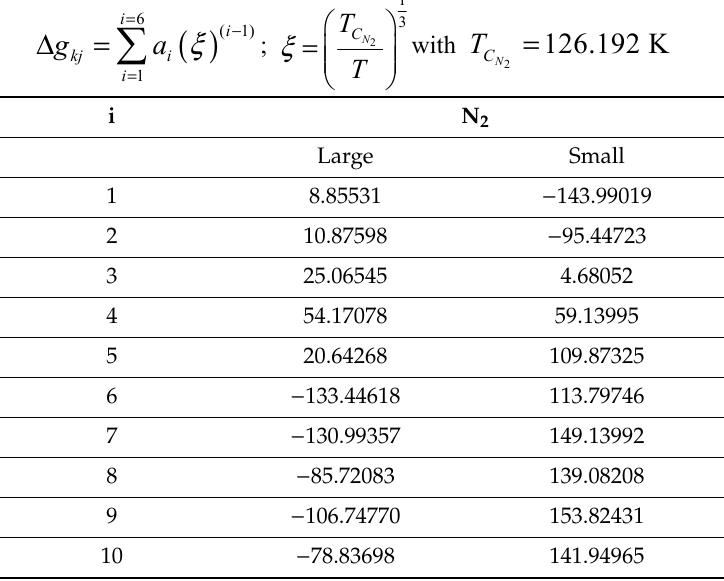
Figure 13. Calculated stability limits for hydrate in temperature pressure projection of the hydrate stability window. Lowest solid curve is for 30 mole per cent CO 2 , followed by25 mole per cent CO 2 , then 20 mole per cent CO 2, , then 15 mole per cent CO 2 , then 10 mole per cent CO 2 and upper solid curve for 5 mole per cent CO 2 . The circles are experimental data from [54] for 10 mole per cent CO 2 , and as such to be compared to the second solid curve from top. Dashed curve temperature pressure stability limits for CH 4